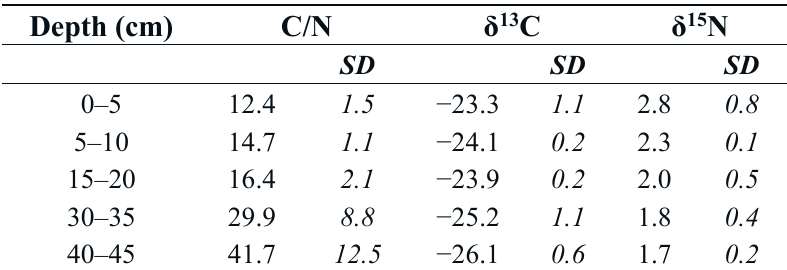
Table 1. Mean C/N ratios, δ 13 C and δ 15 N values of sediments in Avicennia marina stand. Standard deviations are indicated in italics. (Isotopic data were not available for sediments collected beneath the salt-flat and the Rhizophora